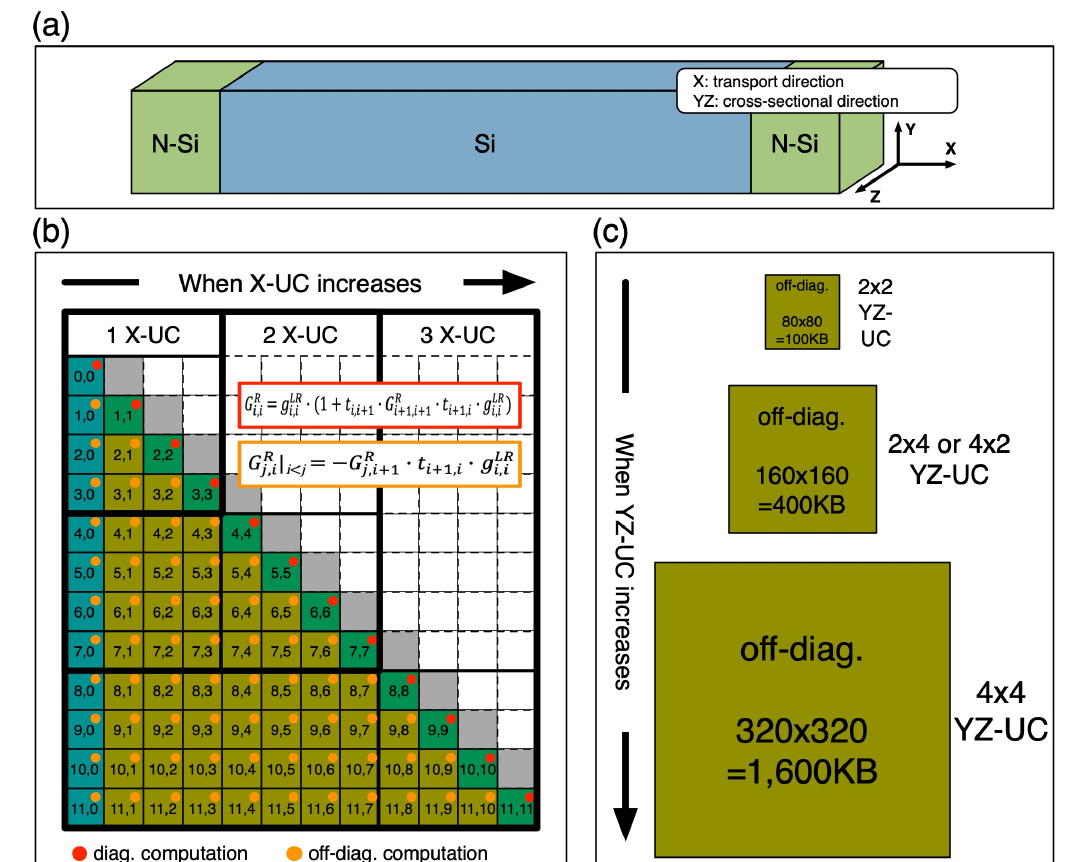
Figure 2. The cost of the sub-matrix multiplication that must be paid according to the X-Y-Z size of the nanostructure to be simulated. ( a ) The nanowire structure that is subjected to quantum transport simulations consists of multiple atomic unitcells (UCs), and the transport happens along the X-direction. The computing cost sharply increases as the nanowire gets larger, so ( b ) the number of off-diagonal sub-matrices is proportional to (X-UC) 2 and ( c ) the size of a sub-matrix increases in proportion to (YZ-UC) 2 , where X-UC and YZ-UC are the number of unitcells along the X-direction and on the YZ-plane of the nanowire,